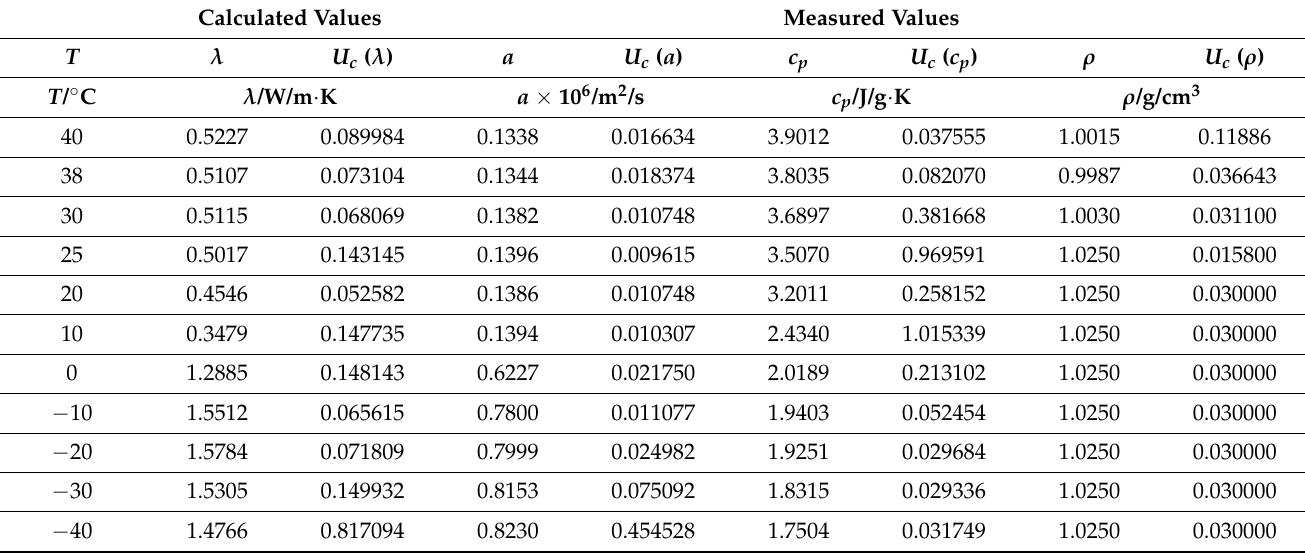
Table 1. Temperature-dependent thermal diffusivity (m 2 /s), specific heat capacity (J/g · K), and density (g/cm 3 ), plus the calculated thermal conductivity (W/m · K) of the Gel-10% solution with their corresponding measurement uncertainties ( U c